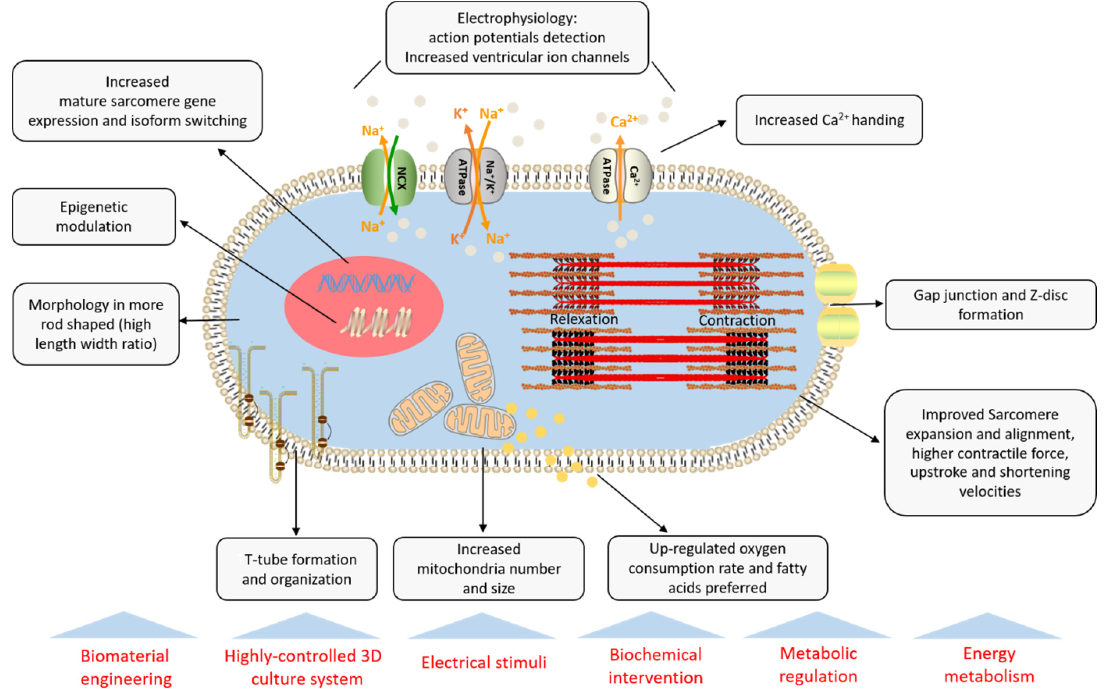
Figure 1. Properties of cardiomyocytes derived from induced pluripotent stem cells. IPSC-CMs feature high expression of key maturation markers, primed ultrastructural morphology, and functional electrophysiology (especially ion channel and contractility), and fatty acid-dependent rather than glycolysis. Current strategies for iPSC-CM production include engineered substrates, electrical stimulation, mechanical intervention, and metabolic modulation with optimized culture conditions.